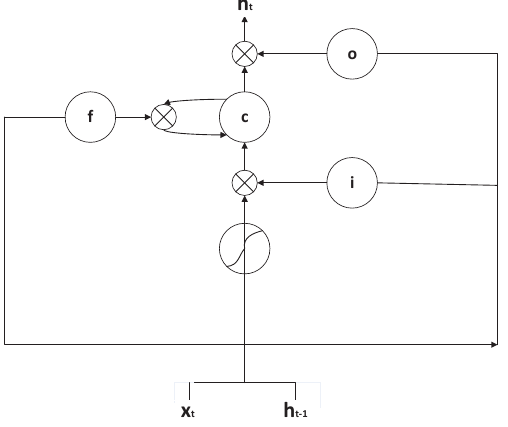
Figure 1. The architecture of an LSTM. i, f, o represents input gate, forget gate and output gate respectively, c indicates the cell activation